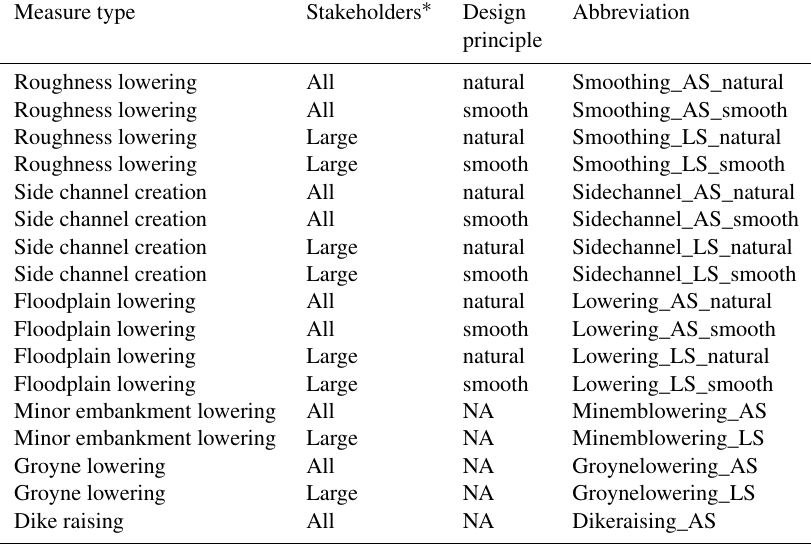
Table 3. Overview of 17 landscaping scenarios: six measures, two locations based on stakeholders (all stakeholders and large estate own- ers), and two design principles (smooth and natural). All measures were evaluated for three sets of hydrodynamic boundary conditions (Q16_dh0.0, Q18_dh0.0, and Q18_dh1.8). The abbreviations are used in results’ figures. Measure type Stakeholders ∗ Design Abbreviation principle Roughness